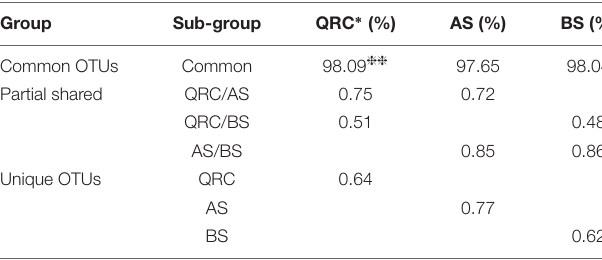
TABLE 2 | Relative abundance of fungi nirK OTUs in different